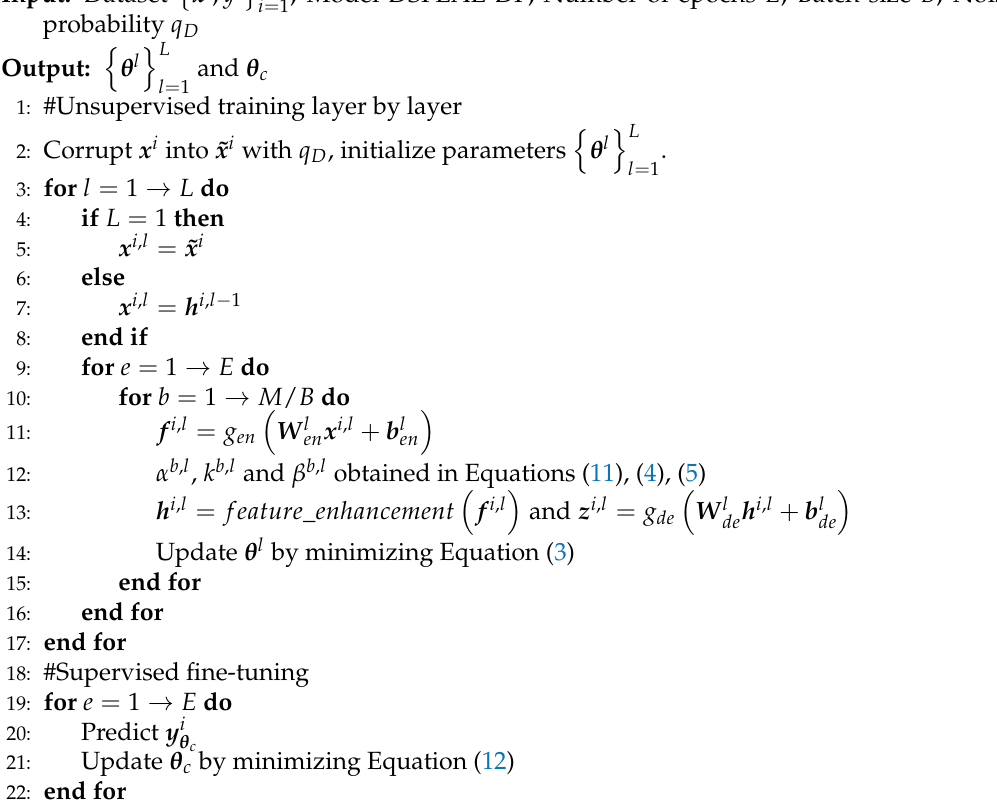
Algorithm 2 Training process of